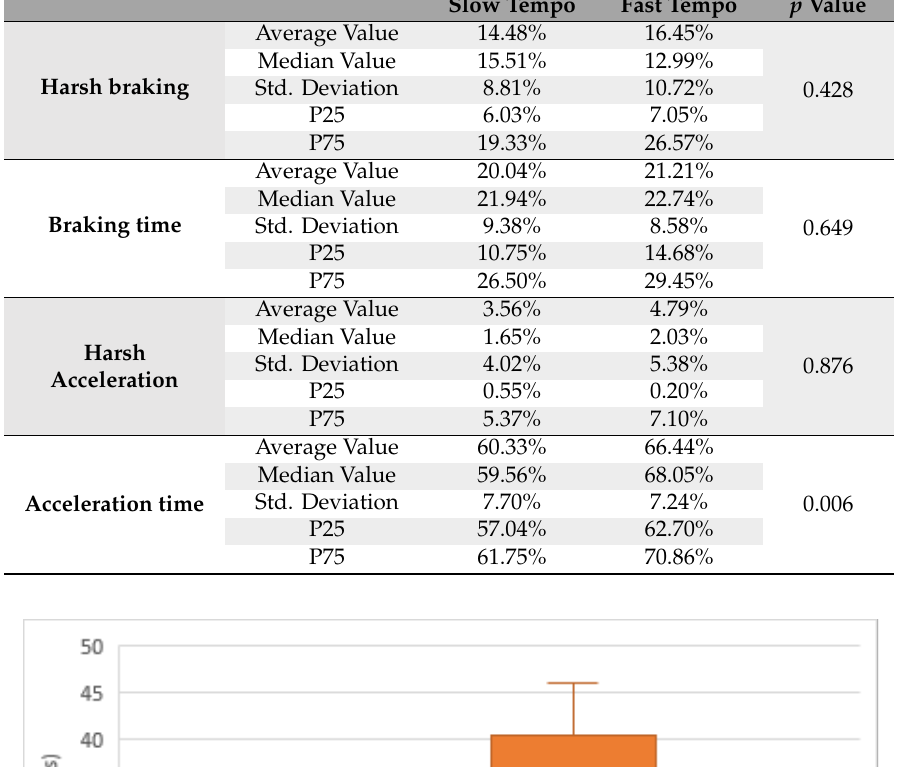
Table 15. Driving behavior grouped by music tempo.